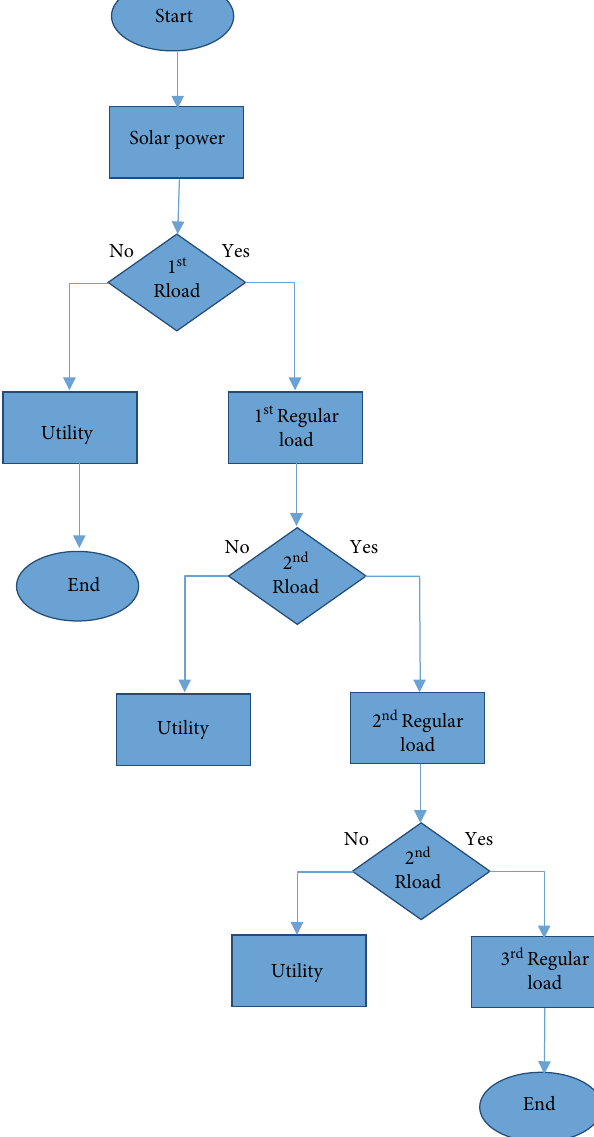
Figure 18: Regular load controller fl